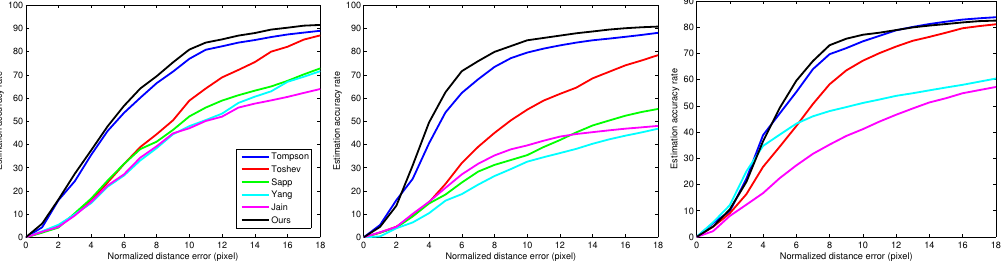
Figure 5. The performance of body joint estimation in planar space on the FLICtest-set. ( a ) Elbow estimation result; ( b ) wrist estimation result; ( c ) foot estimation result.